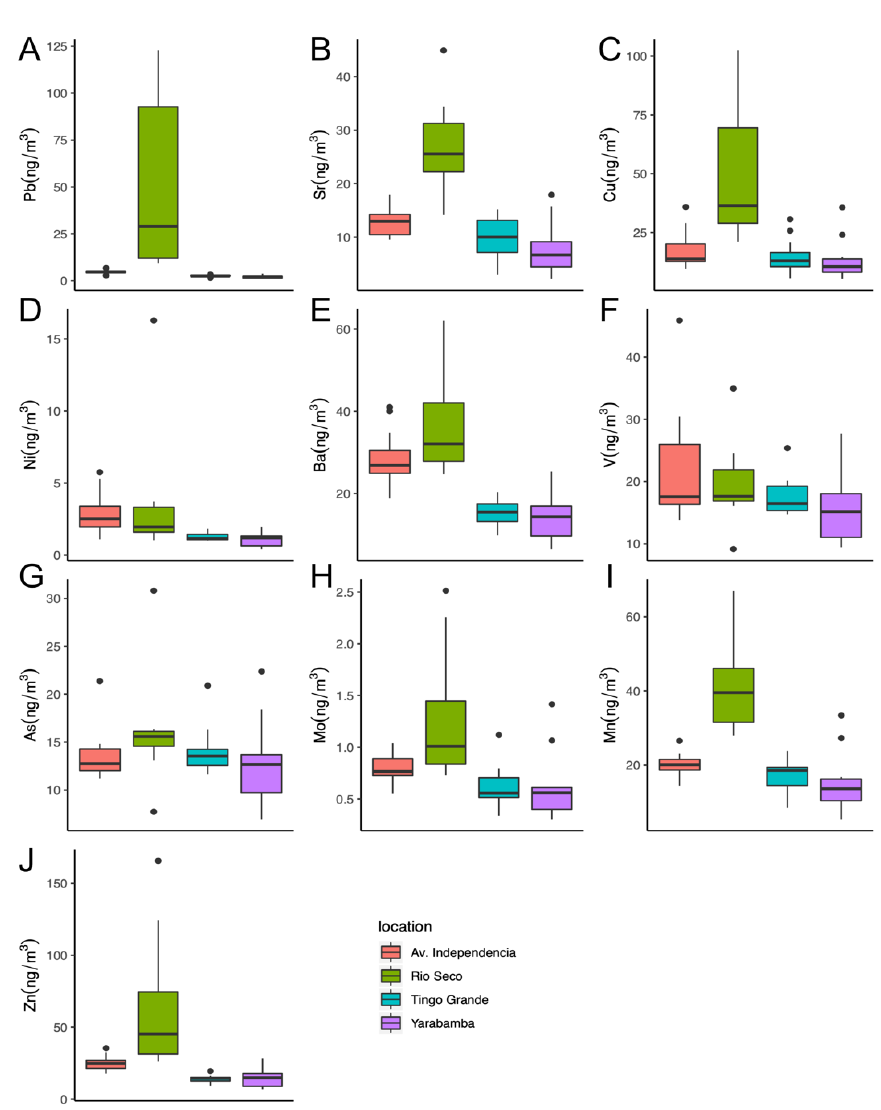
Figure 4. Box plot of the air concentrations (in ng/m 3 ) of trace elements at each site. Table 2. Mass-weighted concentration of elements in PM 10 in each site. Highest mean concentrations are marked in bold font. The unit for trace elements (Pb-Mo) is ppm and for major elements (Fe-Ca) is